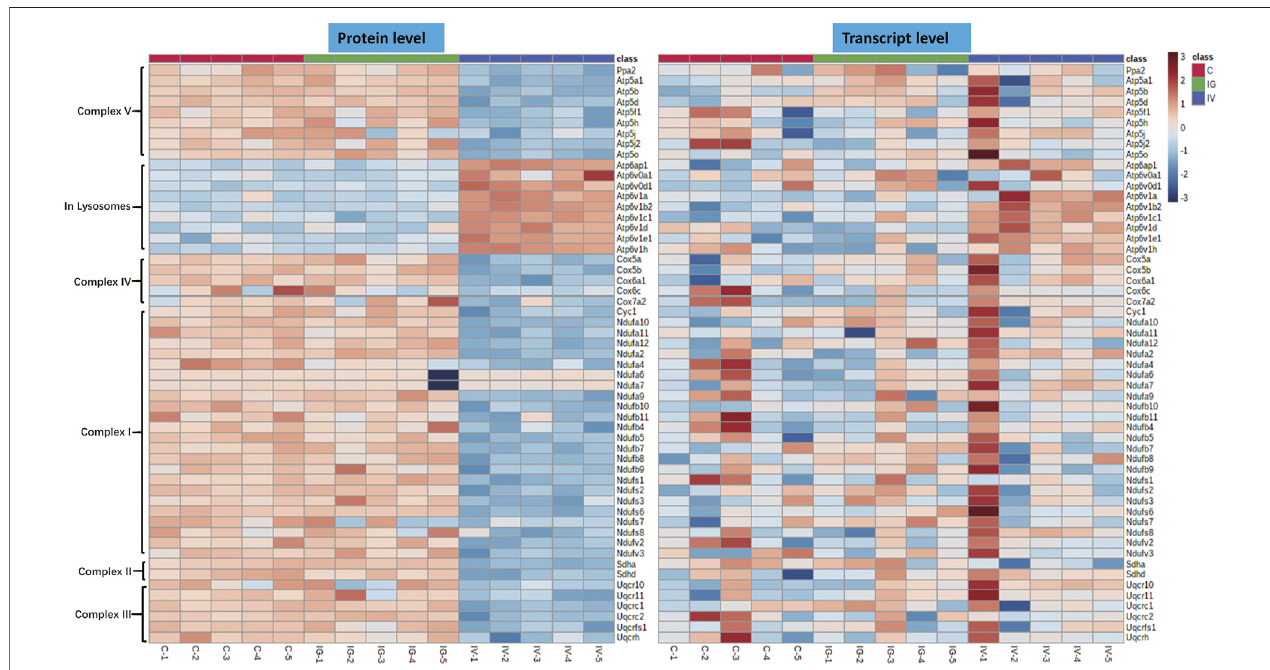
FIGURE 4 | Effect of Mesoporous Silica Nanoparticles (MSNs) administered by different routes (IV and IG) on mitochondrial oxidative phosphorylation complexes. Heatmaps of genes and proteins involved in respiratory chain complexes I, II, III, IV and V of mitochondria and V-type proton ATPase of lysosomes.